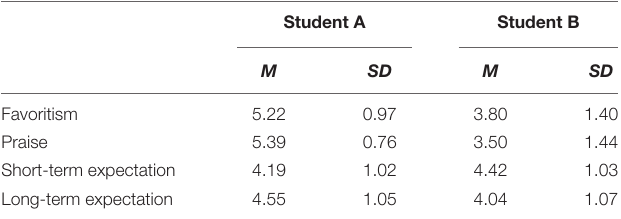
TABLE 2 | Means and standard deviations of participants’ Favoritism, Praise, Short-term, and Long-term expectations toward Students A and